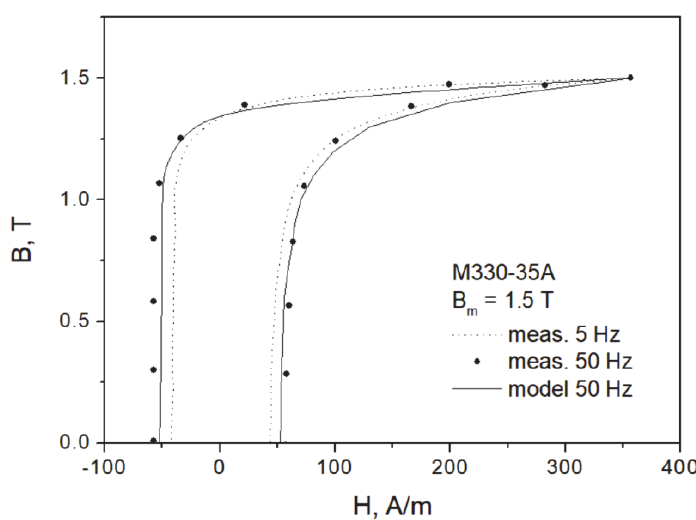
Figure 10. Measured and modeled hysteresis loop for Bm = 1.5 T, f = 50 Hz, M330-35A grade.